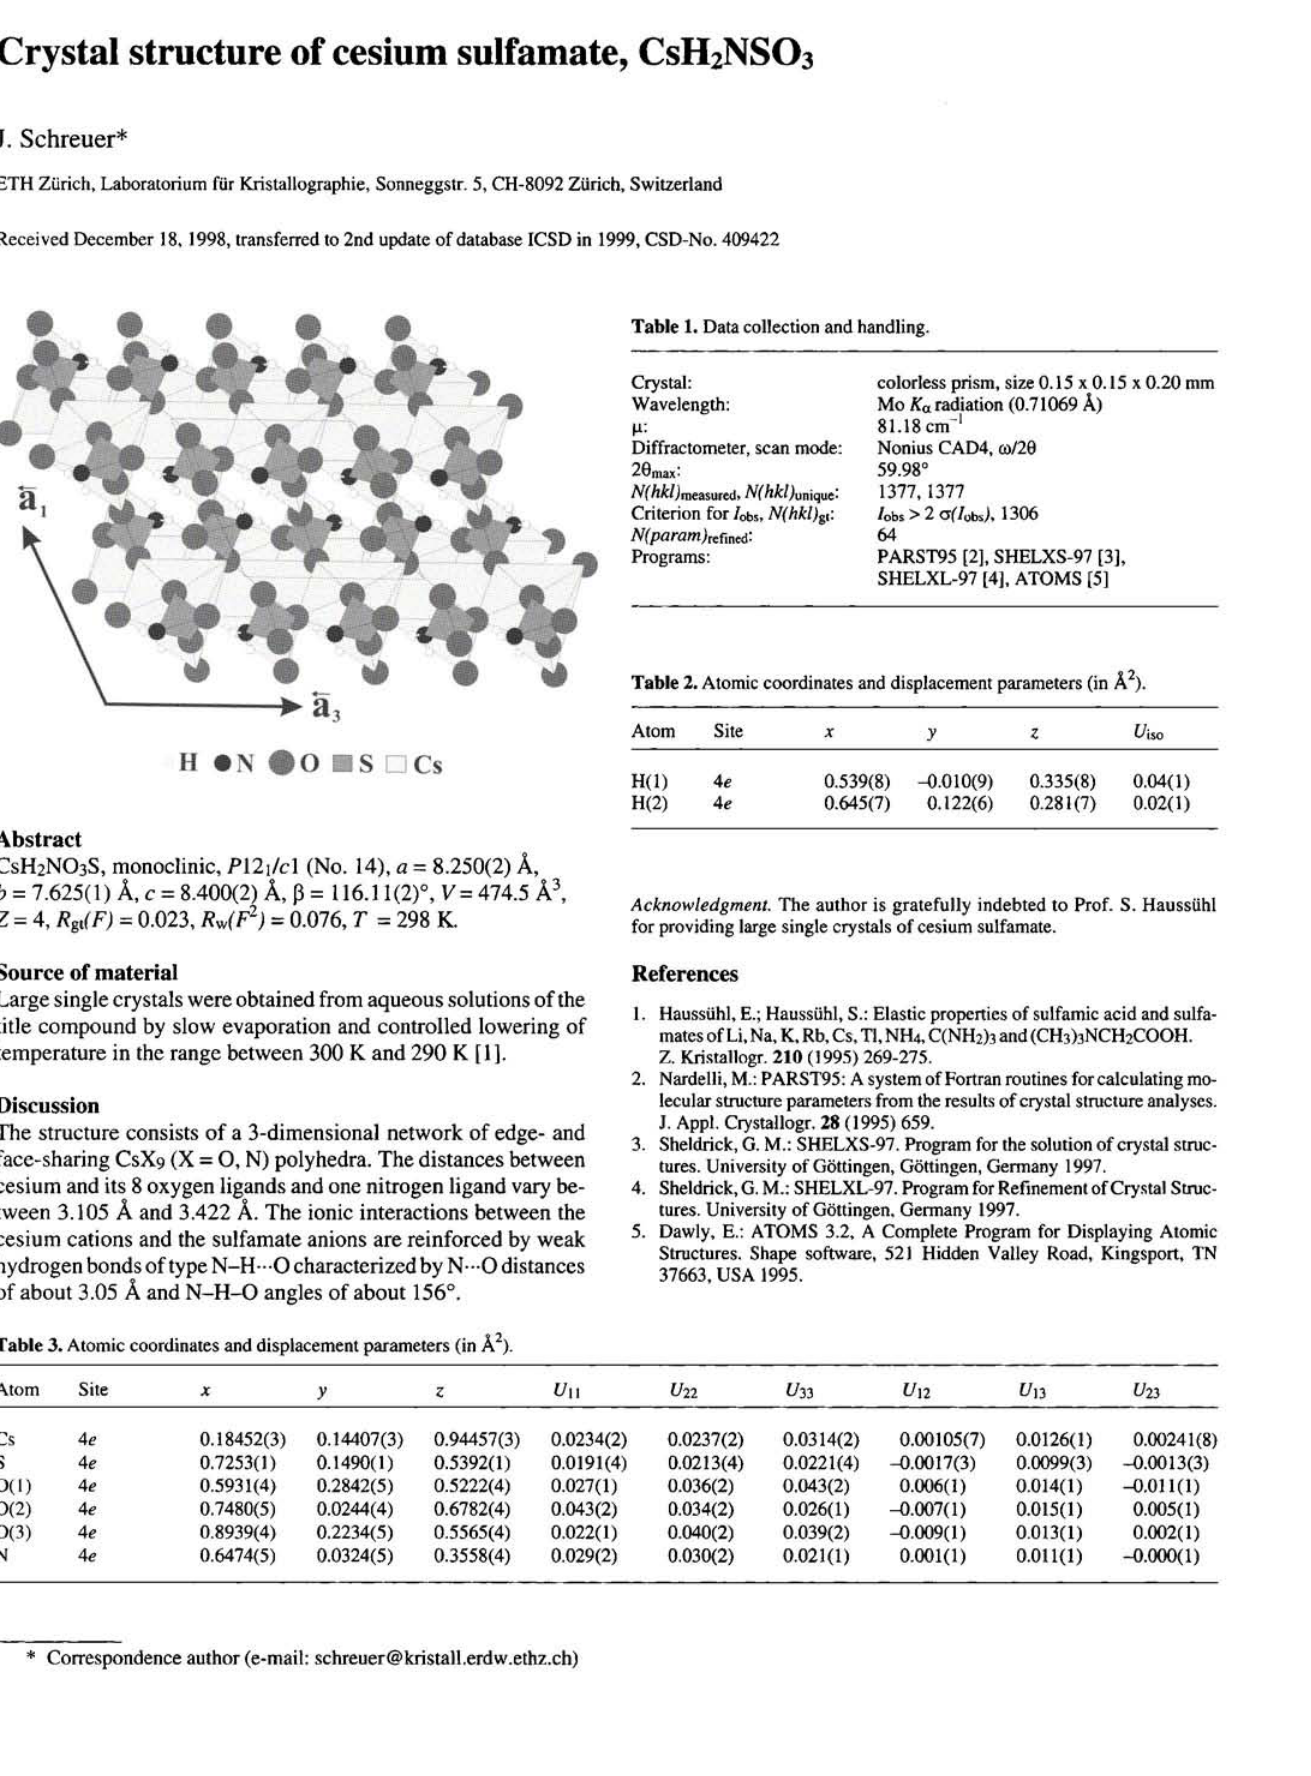
Table 1. Data collection and handling.